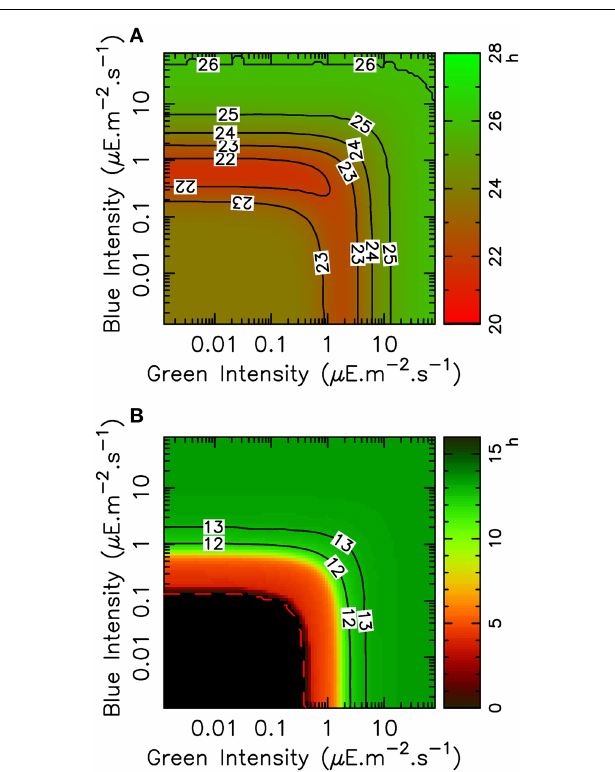
FIGURE 4 | Variation of FRP and TOC1 expression peak timing with blue and green light intensities in the mathematical model. (A) Variation of the free-running period with light intensities in green and blue light, shown as a heat map and with level lines (solid black lines). (B) Timing (ZT) of the TOC1 expression peak in LD 12:12 entrainment condition as a function of light intensities in green and blue light, shown as a heat map with level lines (solid black). The black area indicates the region where the circadian clock does not lock to the light/dark cycle.